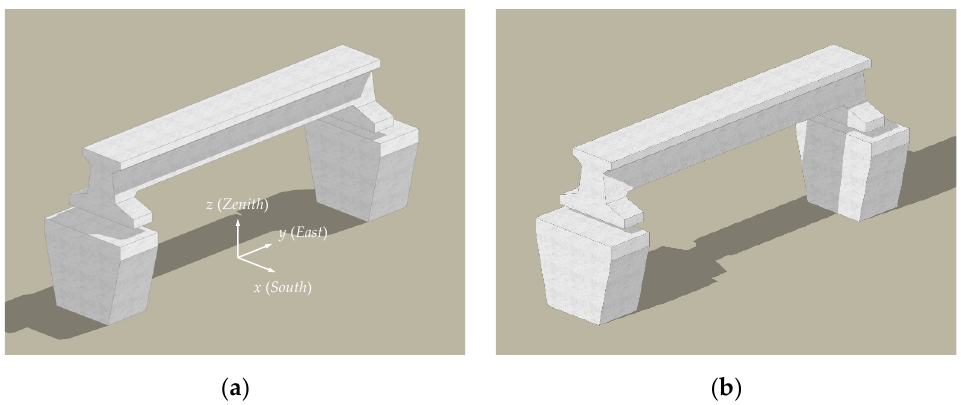
Figure 3. Simulation of solar shadow distribution on the structure on 23 July 2019. ( a ) 09:00; ( b ) 15:00.